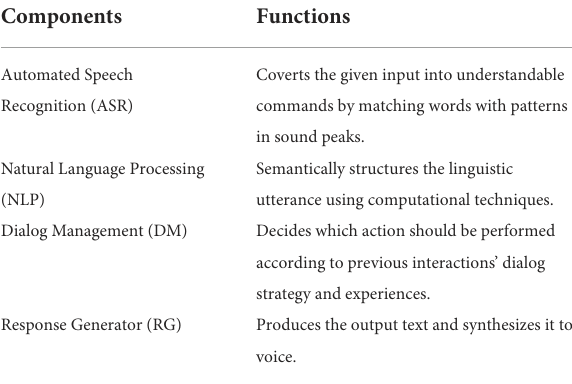
TABLE 1 Components of voice intelligence (Pieraccini, 2012; Hirschberg and Manning, 2015; de Barcelos Silva et al., 2020; Amazon,